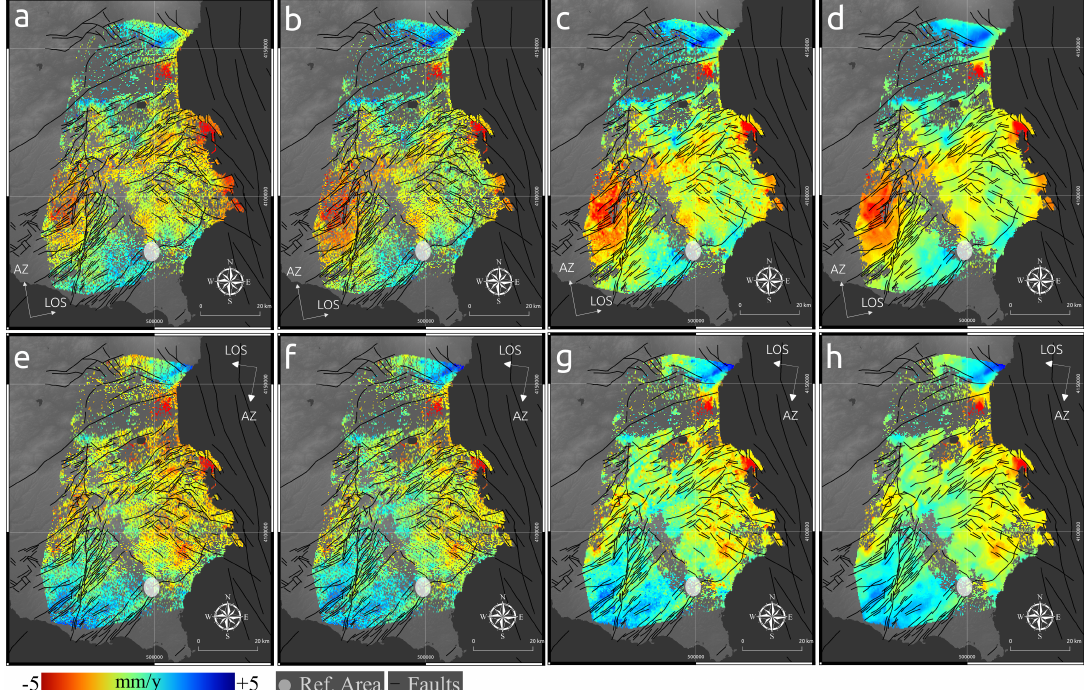
Figure 4. ( a – h ) Mean LOS velocities (upper row: ascending track; lower row: descending track): ( a , e ) corrected for orbital and DEM error; ( b , f ) tropospheric corrected datasets; ( c , g ) gap-filled dataset; ( d , h ) multi-directional Lee filtered